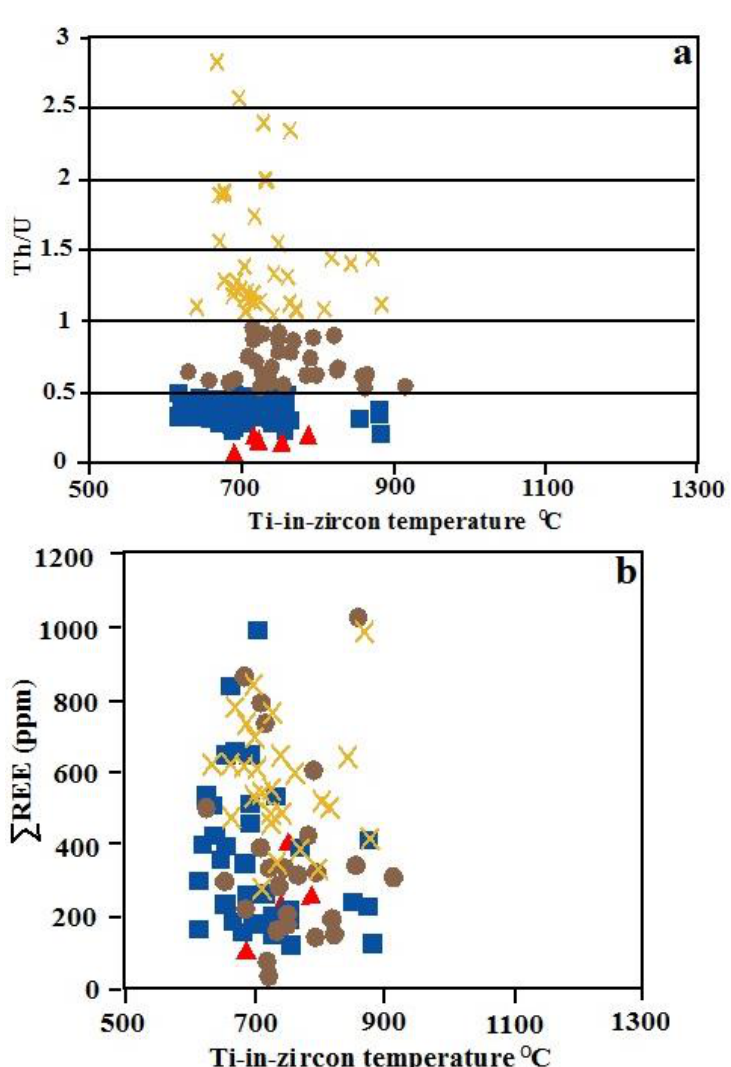
Figure 8. ( a ) Th/U ratio versus Ti-in-zircon temperature ( ◦ C) with some grouping of plots, and ( b ) ∑ REE (ppm) versus Ti zircon temperature ( ◦ C) showing correlations within some zircons from the southern Meiganga gold-bearing placers. Some plots are close while others scattered. Red triangles represent zircon with Th/U < 0.2; blue squares represent zircon with Th/U ratios [0.2 to 0.5]; brown circles represent zircons with Th/U ratios [>0.5 to 1.0]; and stars represent zircons with Th/U > 1.0.